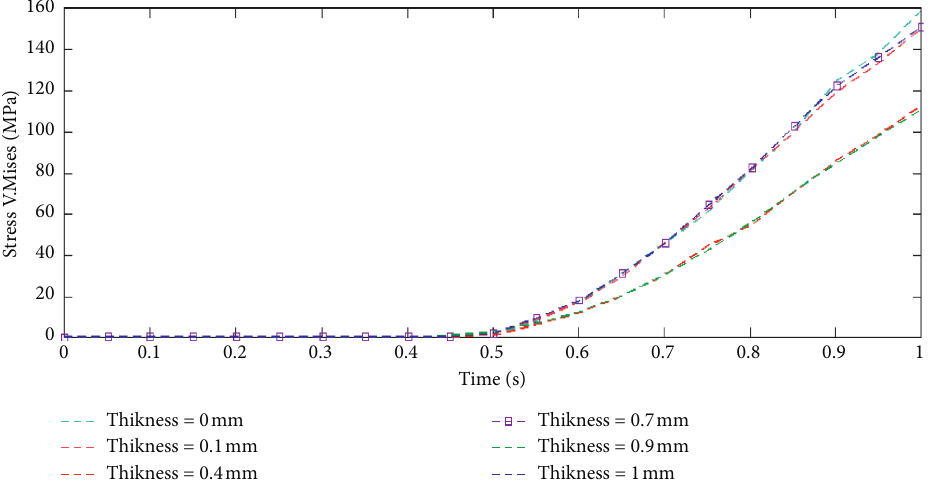
Figure 4: Stress evolution as function of time and of elastic piece thickness at an element of the lower plate. Table 2: The results of the Pearson test of correlation between the stress and the elastic piece thickness. Thickness Stress Pearson correlation 1 − 0.0906 Thickness Sig.(bilateral) 0.7794 N